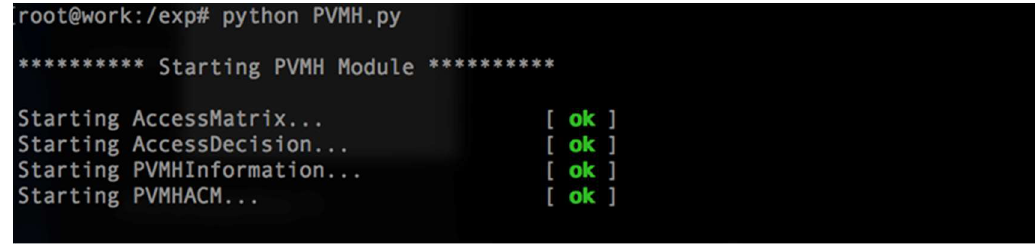
Figure 7. Enable the PVMH module.